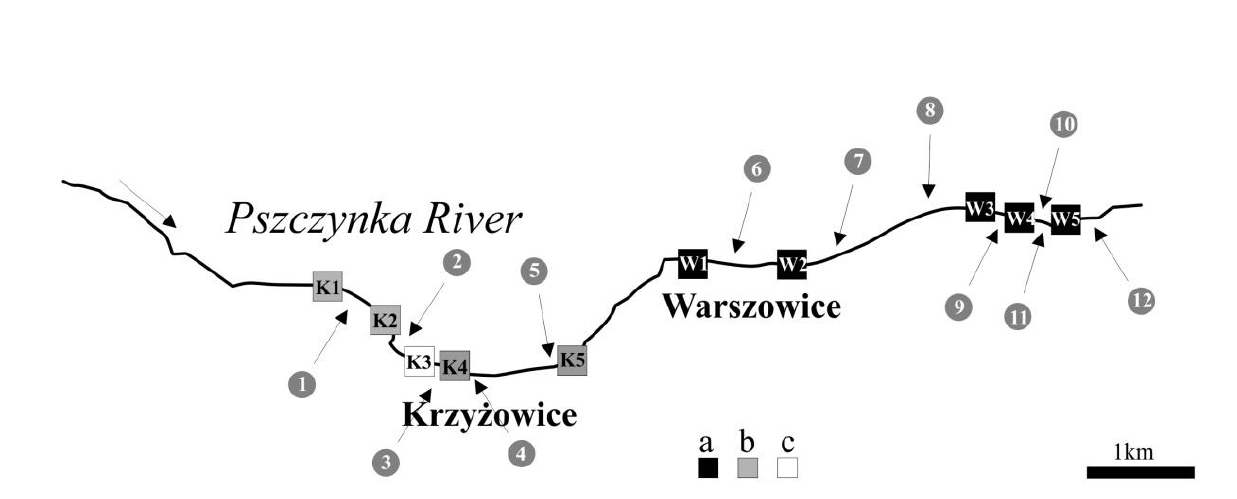
Fig. 4. Pszczynka River and objects affecting its ecological status in the area of Pawłowice community (author's